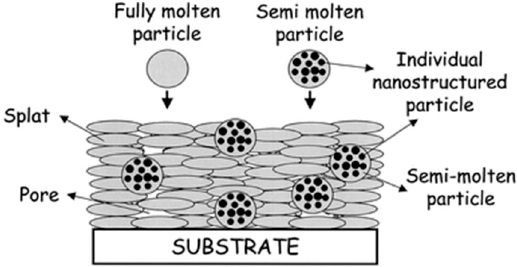
Figure 3. Typical schematic of the bimodal microstructure of thermal spray coatings formed by fully molten and semi-molten nanostructured agglomerated particles [64]. Reprinted with permission from ref [64]. © 2007 Springer Nature.